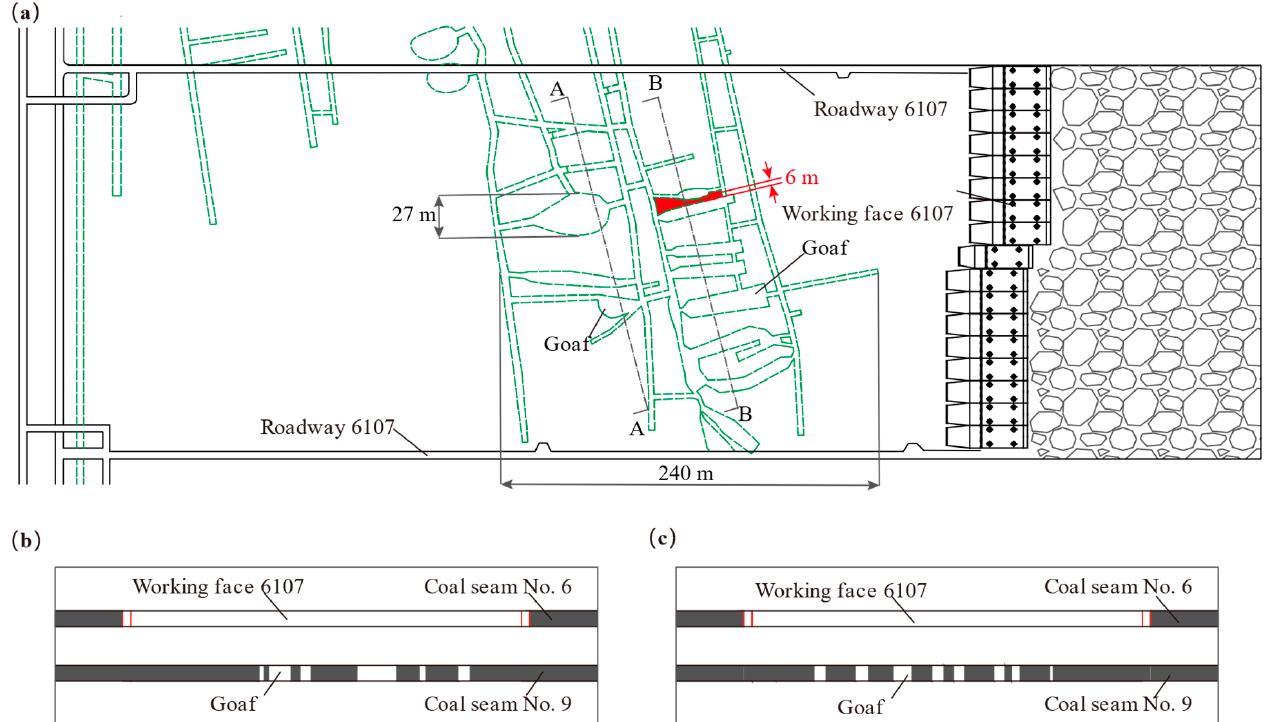
Figure 1. Relative positional relationship between the coal pillar and 6107 working face [25] ( a ) Face plan of 6107 working face ( b ) Sectional drawing at section line A ( c ) Planning view at section line B.